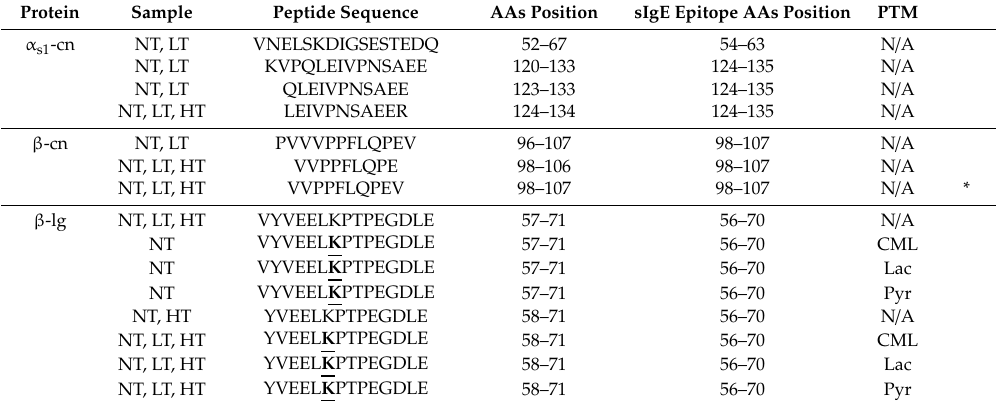
Table 4. Digestion-derived peptides covering sIgE binding epitope sequences 1 , identified on the basolateral side of the Caco-2 cell monolayer. Peptides were generated after digestion of cow’s milk protein, non-treated (NT), heated at low temperature (LT), and heated at high temperature (HT), in an infant in vitro model. Amino acids (AAs) position indicates the position within the proteins including the signal peptide. Peptides derived from α s1 -casein ( α s1 -cn), β -casein ( β -cn), and β -lactoglobulin ( β -lg). Peptides with and without post translational modification (PTM) to lactosyl lysine (Lac), glucosyl lysine (Gluc), N ε -carboxymethyllysine (CML), and pyrroline (Pyr) are shown. Digestion-derived peptides covering the exact sequence of a sIgE binding epitope are indicated with